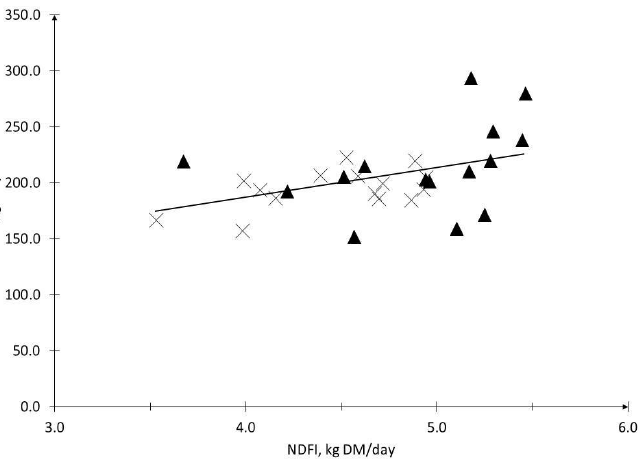
Figure 2. The relationship between neutral detergent fiber intake (NDFI) and CH 4 production of steers fed moderate-fiber (MF, black triangle) and high-fiber (HF, cross) diets. r 2 = 0.45, p = 0.013, and Y = 27.52x+ 74.89.